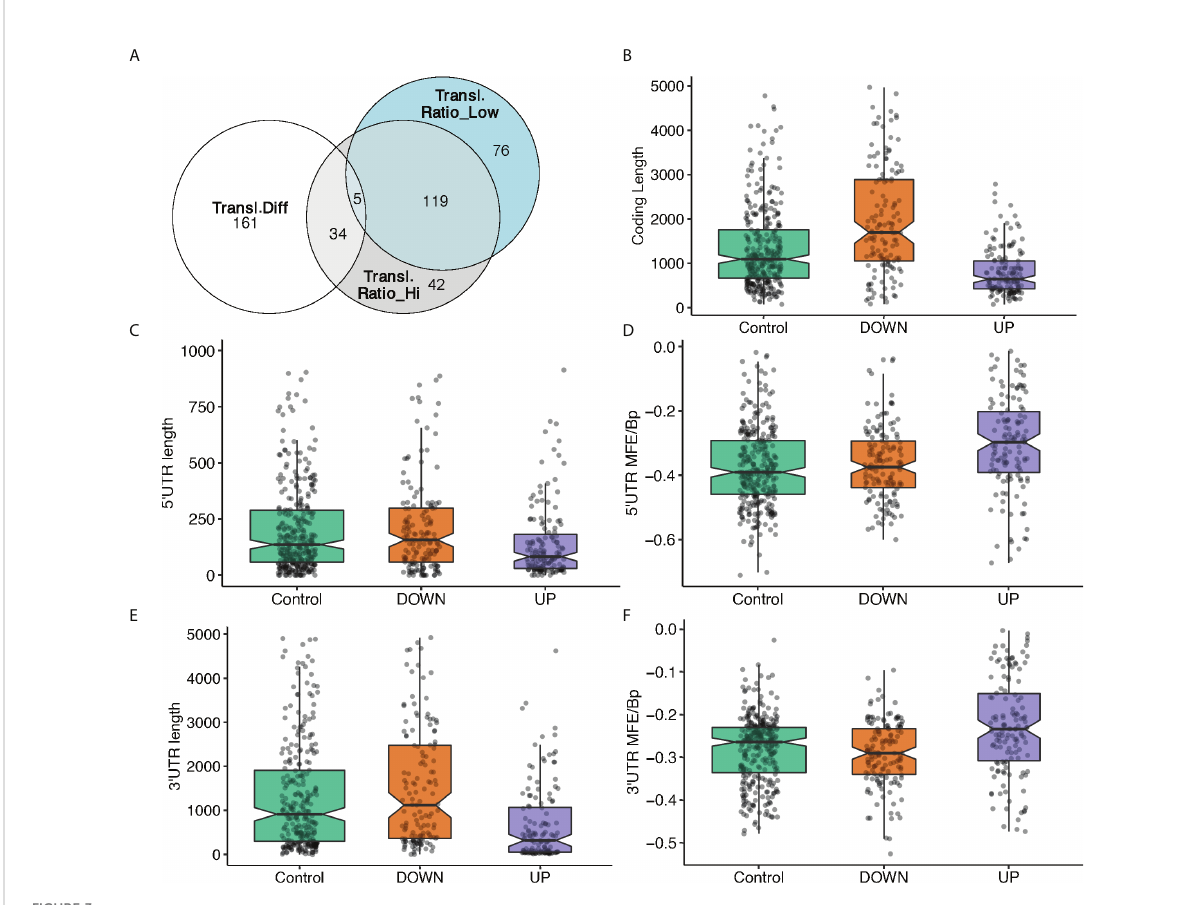
FIGURE 3 mRNA feature analysis of the 3 groups of differentially translated mRNAs. (A). Venn diagram showing the overlap between the 200 mostly translated genes: best translated in high glucose (grey circle), best translated in low glucose (blue circle), mRNAs with the most difference ones in ranking between low and high glucose (white circle). (B-F). mRNA features analyses of 3 groups of mRNAs based on the difference in translation ratio between high and low glucose. Higher (UP) or the lower (DOWN) translation ratio in high glucose, and a control group with no signi fi cant changes between high and low glucose. MFE/Bp is the folding free energy normalized by the length (see Material and Methods). (B), coding length; (C), 5 ’ UTR length, (D), 5 ’ UTR MFE/Bp, (E), 3 ’ UTR length, (F), 3 ’ UTR